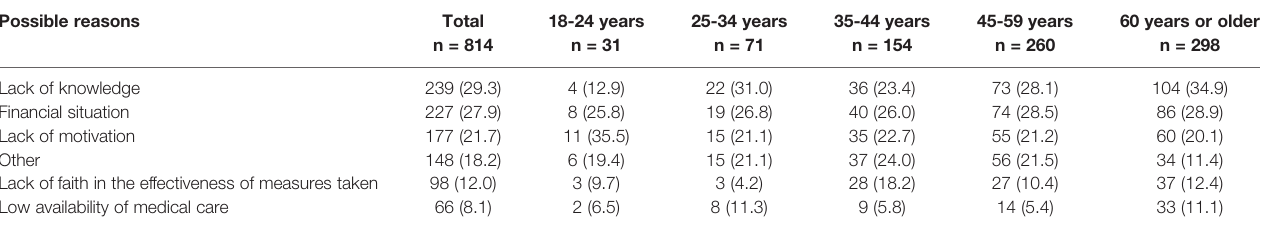
TABLE 2 | Barriers to adherence to healthy lifestyle instructions in the study respondents: comparison by age group. Possible